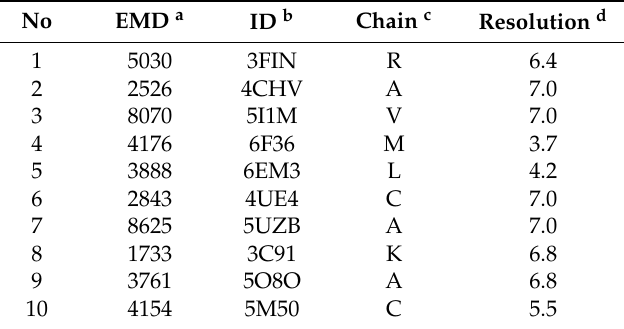
Table 1. The information of the experimental volumes used.